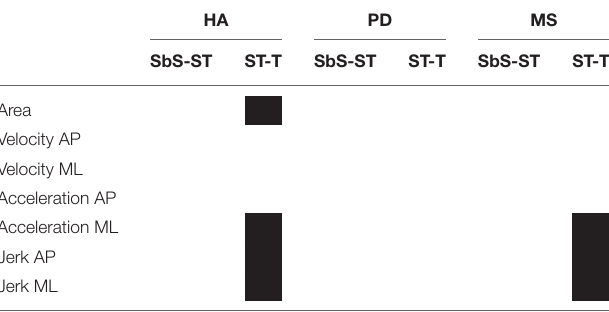
TABLE 4 | Significant changes of sway parameters between